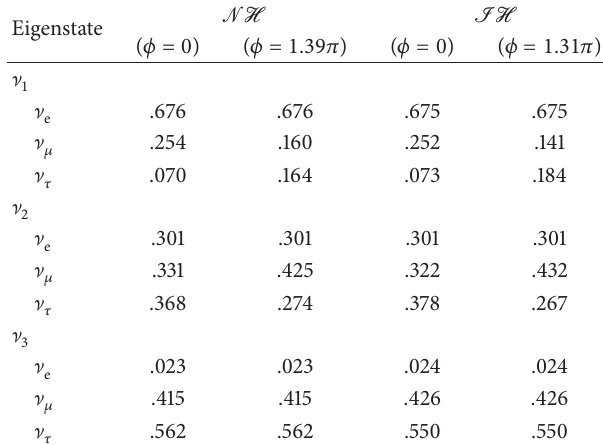
Table 2: Results of the global 3 ] oscillation analysis, in terms of best fit values and allowed 1 𝜎 range for the 3 ] mass-mixing parameters relevant for our analysis as reported in [35]. The last column is our estimate of the 𝜎 while assuming symmetric uncertainties.